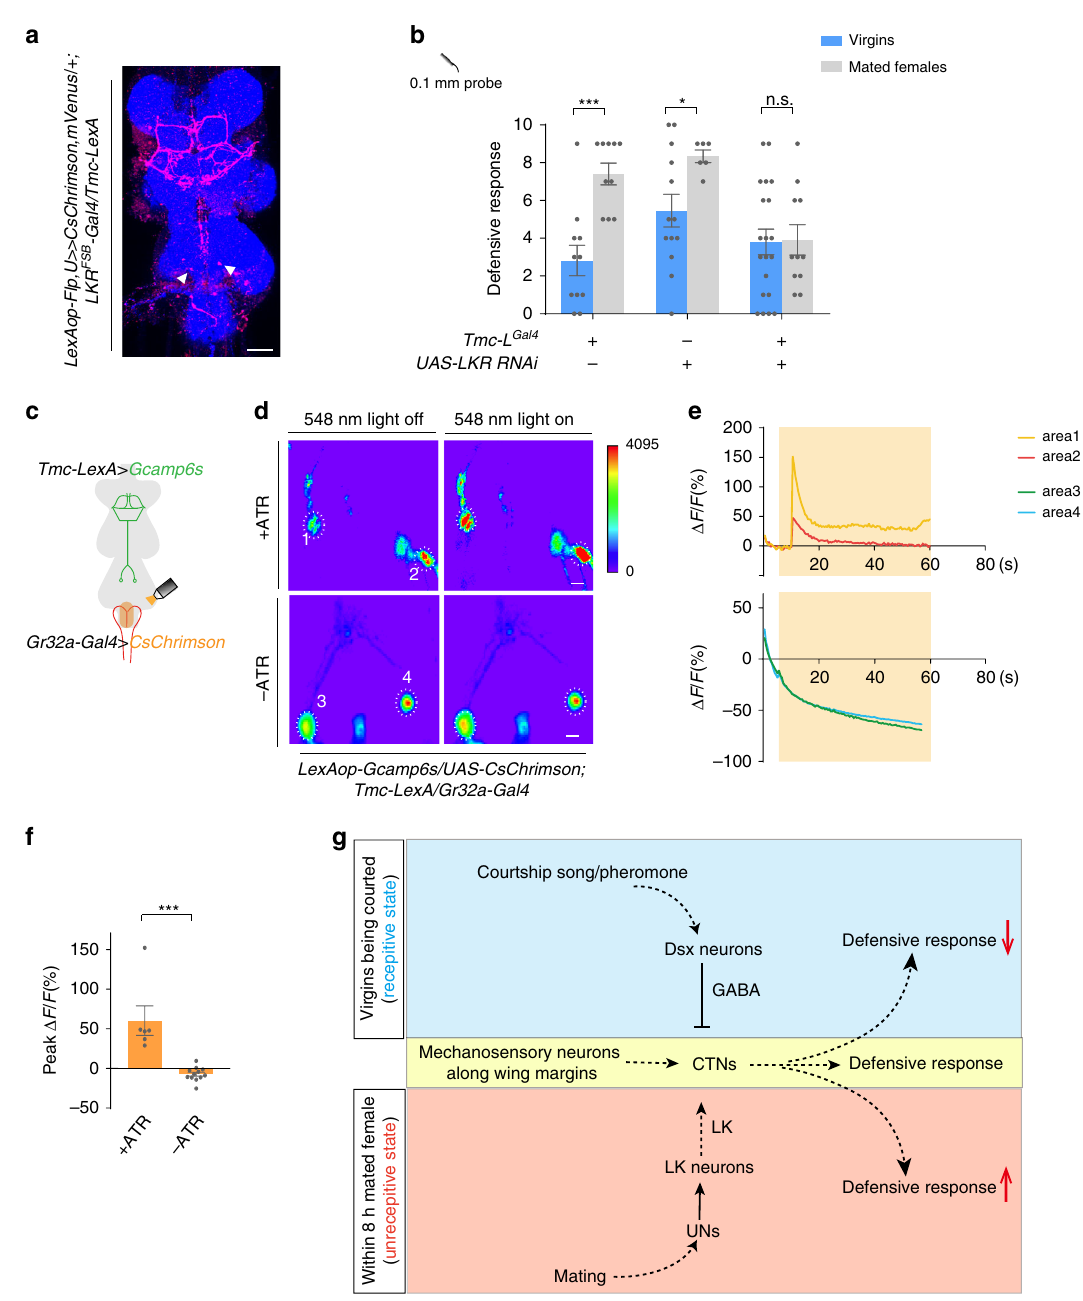
Fig. 6 CTNs are activated by LK to induce increased defensive response in mated females. a Intersection between Tmc neurons and LKR neurons (red). White arrow indicated the cell bodies of CTNs. Blue: nc82. Scale bar represented 50 μ m. b Knocking-down LKR in Tmc-L neurons blocked the mating- induced increase of defensive response. n = 11, 10, 13, 6, 20, and 11 (from left to right). *** p < 0.001, * p < 0.05, p > 0.05 (n.s.), n.s., two-tailed unpaired t tests. c Schematic for assays in ( d ). d Representative imaging of Ca 2 + responses in CTNs ’ cell bodies in the VNC before (left) and after (right) activating UNs with CsChrimson. Upper panels: fl ies fed with all-trans retinal (ATR). Lower panels: without ATR. The cell bodies of CTNs were cycled with white dashed lines. Numbers indicated different cell bodies. Scale bar represented 50 μ m. e Representative traces of Δ F / F of CTNs ’ cell bodies showed in ( d ) after UNs activation. f Ca 2 + signal of fl ies supplied with ATR (left bar, n = 6) was elevated by UNs stimulation compared with fl ies without ATR (right, n = 12). *** p < 0.001, two-tailed Mann – Whitney nonparametric test. g Working model for courtship and mating mediated behavioral switch of defensive response in female fl ies. Error bars indicate mean ± SEM, n.s., not signi fi cant. Source data are provided as a Source Data fi